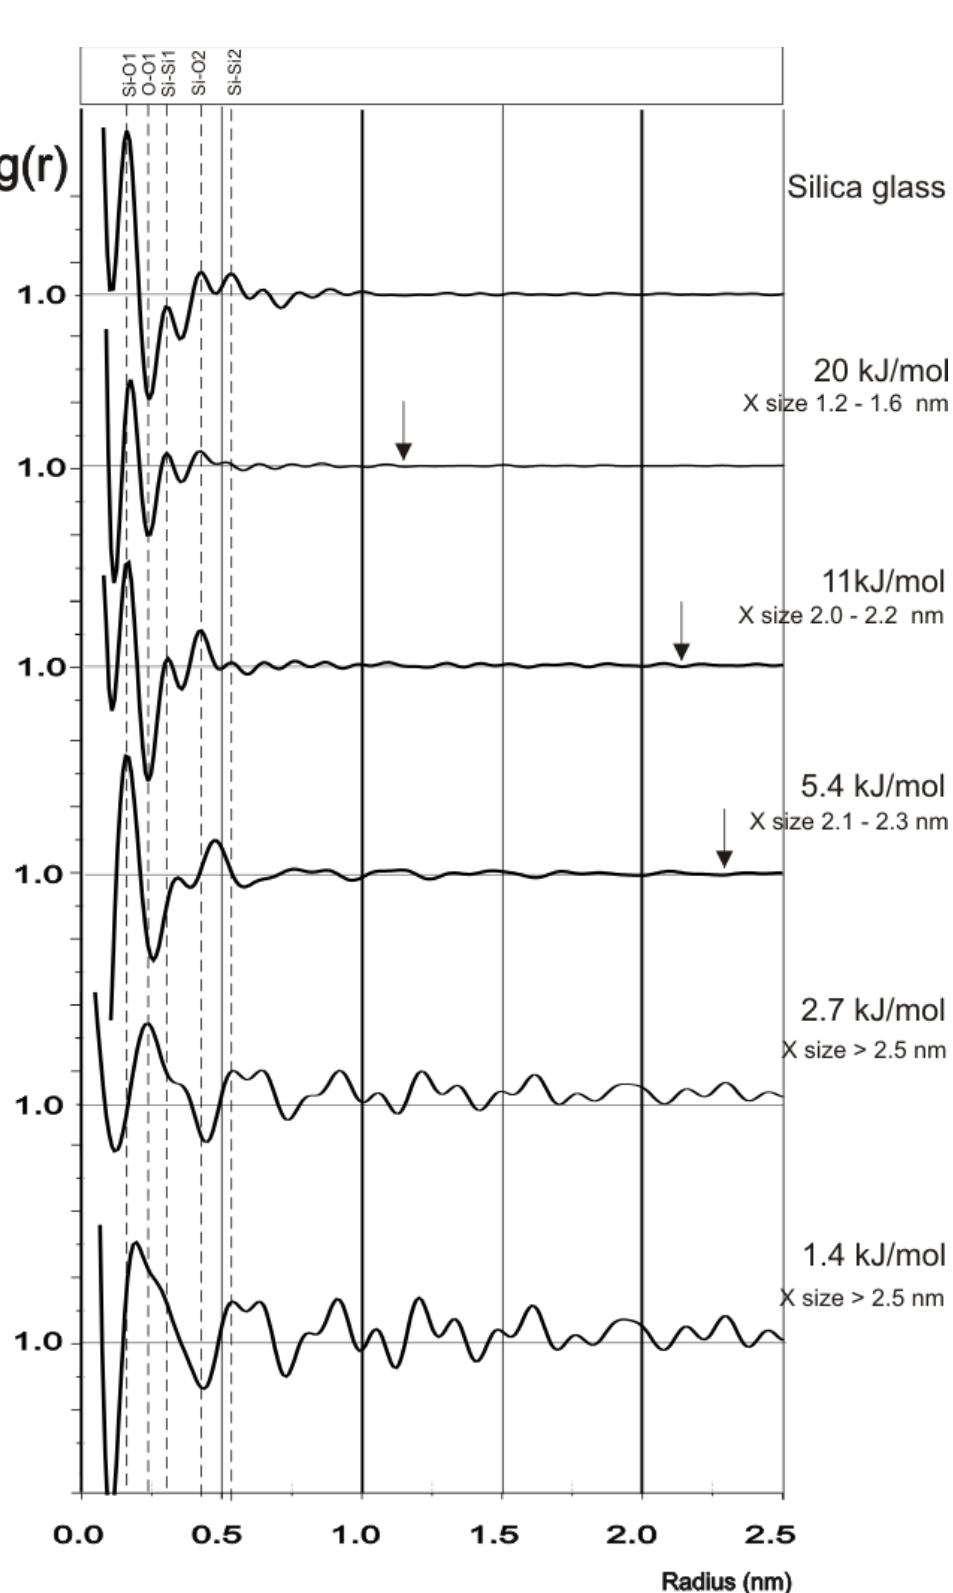
Figure 3. Pair Distribution Function analysis of the quartz samples at different specific energy of shear stress.